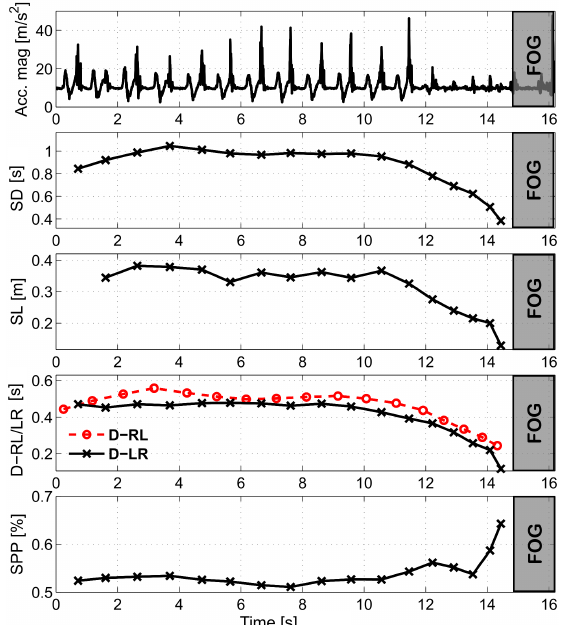
Figure 3: A prior-to-FoG session , expressed in raw data from acceleration and from gait parameters.